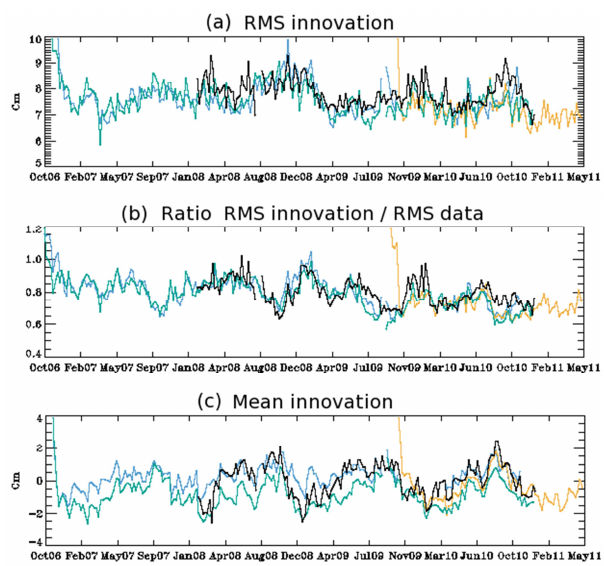
Fig. 16. Time evolution of sea level anomaly (SLA, m) data assimilation statistics averaged over the whole HRZ domain: RMS of innovations (a) ; RMS of innovations divided by quadratic mean of SLA data over the same region (b) ; and mean innovation (c) . The colours stand for different MyOcean versions of HRZ: HRZ V0 (black), HRZ V1 (blue), HRZ V1V2 (orange) and HRZ DEV (green). These scores are averaged over all seven days of the data assimilation window, with a lead time equal to 3.5 days.